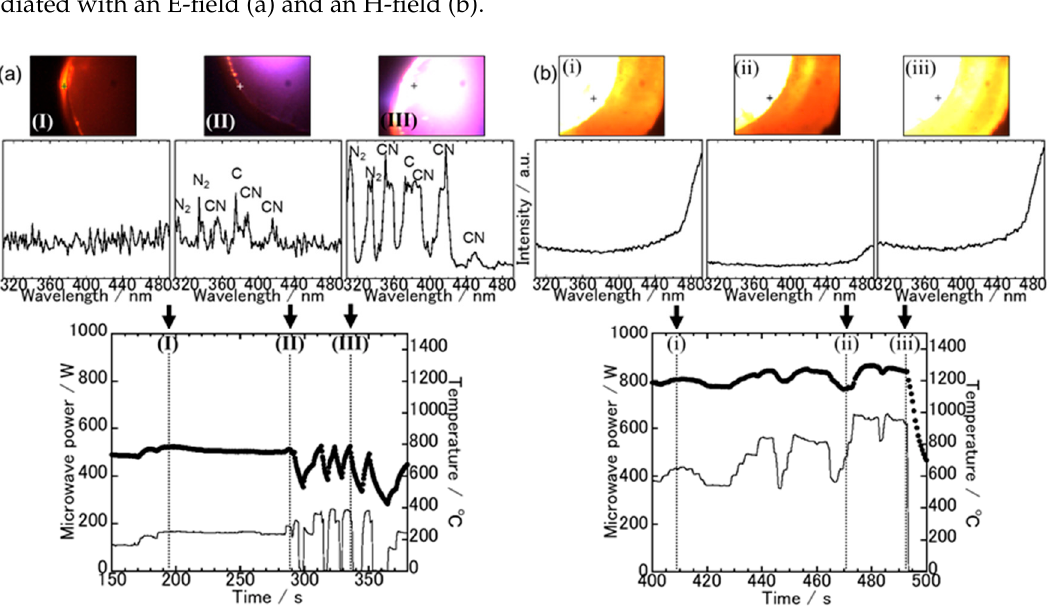
Figure 2. Temperature and microwave power profiles of the hematite and carbon mixture irradiated with an E-field ( a ) and an H-field ( b ). with an E-field ( a ) and an H-field ( b